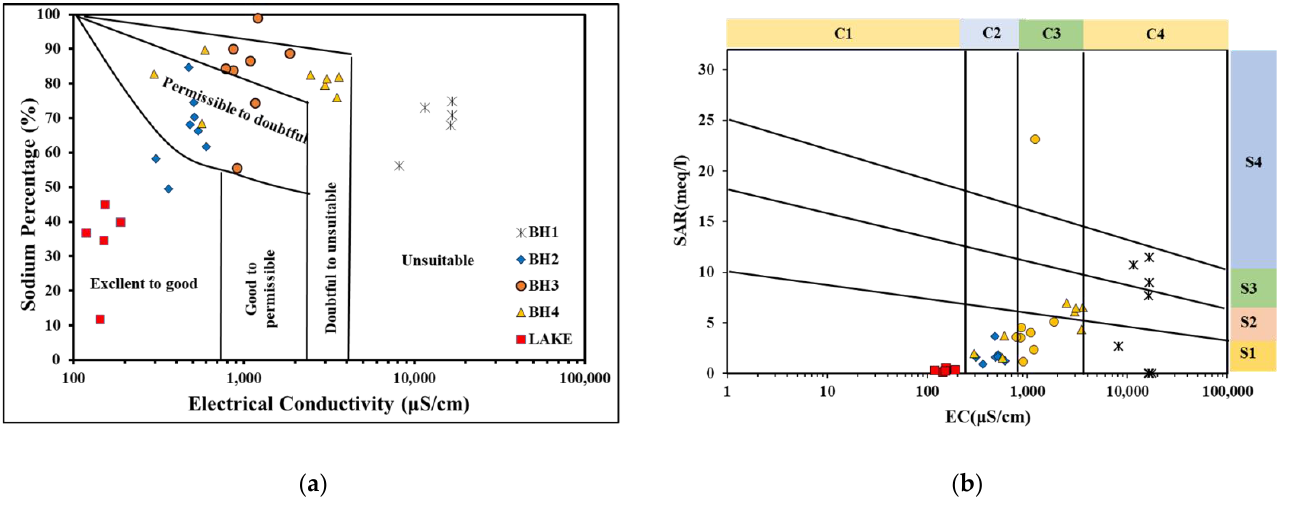
Figure 9. ( a ) Suitability of groundwater for irrigation in the Wilcox [58] diagram, ( b ) US Salinity Laboratory (USSL) [45] diagram for the four boreholes. Note: S1, S2, S3 and S4 represent low, medium, high and very high sodium hazard, respectively, whereas C1, C2, C3 and C4 represents low, medium, high and very high salinity hazard, respectively.